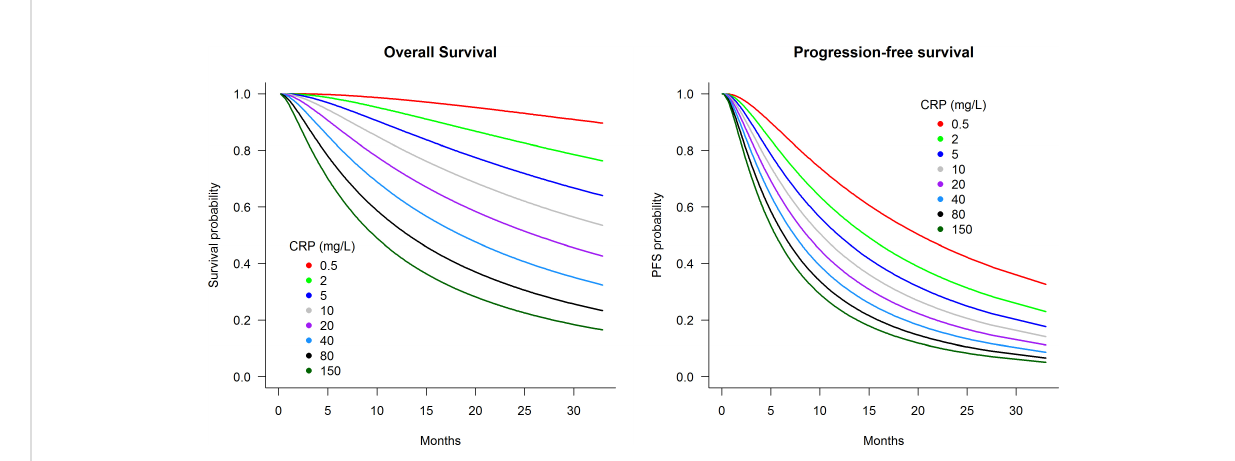
FIGURE 2 Predicted survival curves according to pre-treatment C-reactive protein level for patients treated with atezolizumab plus